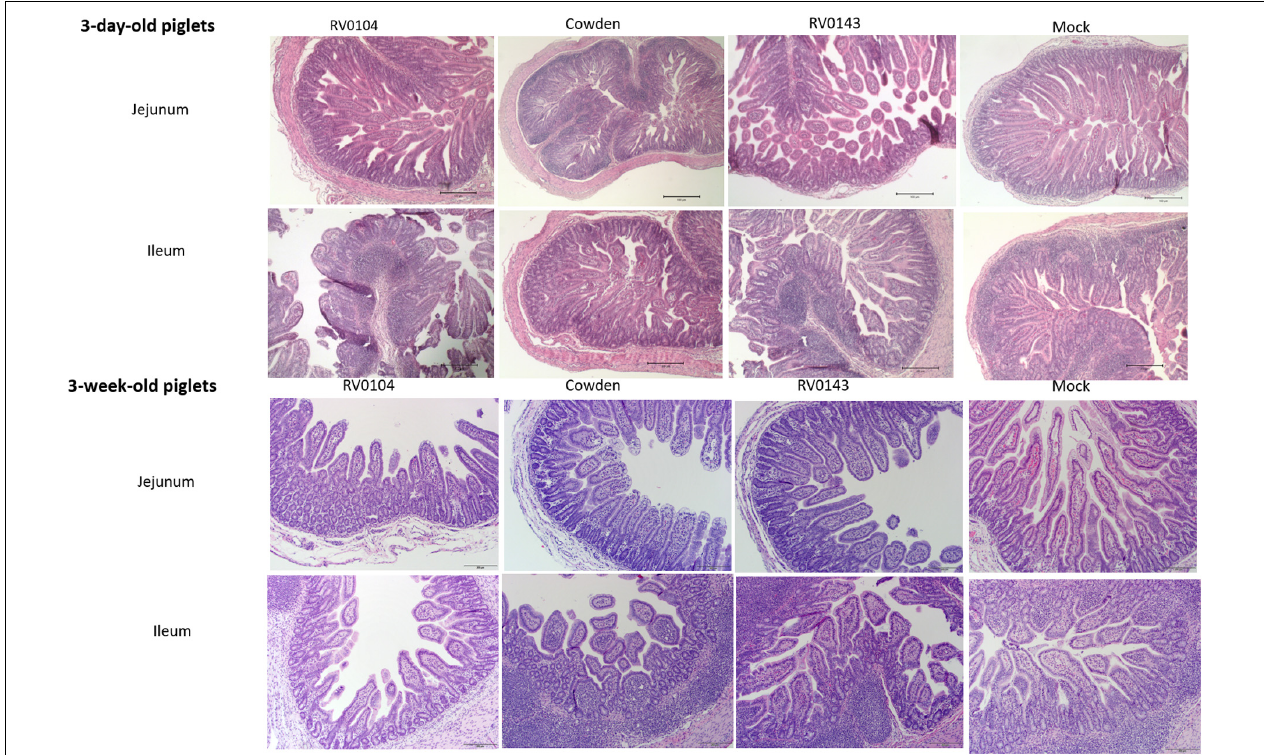
FIGURE 5 | Villous atrophy and structural changes in jejunum and ileum of PRVC (Cowden, RV0104, and RV014) inoculated piglets at PID3. Tissues were preserved in 10% formalin before Hematoxylin and eosin staining. The images were captured using the imaging microscope Olympus B × 41 with camera Olympus DP72 and Olympus CellSens software at 10 ×